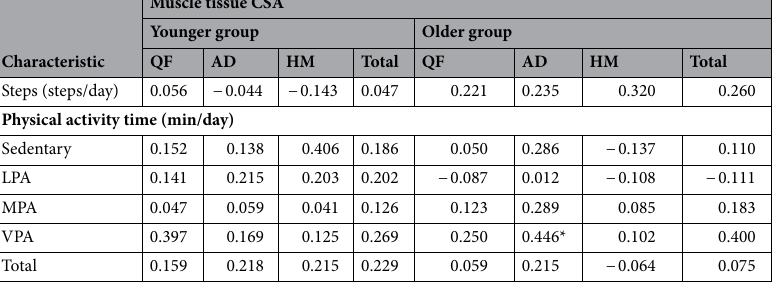
Table 3. Correlation between physical activity and muscle tissue cross-sectional area (CSA) in the younger and older groups. * P < 0.05, QF quadriceps femoris, AD hip adductors, HM hamstrings, LPA light-intensity physical activity, MPA moderate-intensity physical activity, VPA vigorous-intensity physical